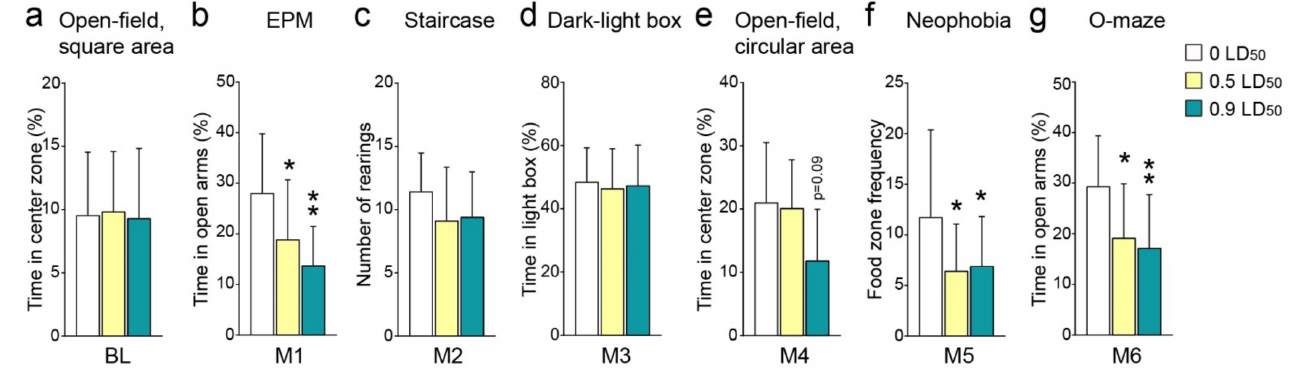
Figure 2. Development of anxiety-like behavior caused by NIMP intoxication. Anxiety-like behaviors were evaluated in NIMP-exposed and CTL animals using a different test every month ( n = 14 for 0 LD50; n = 15 for 0.5 LD50 and n = 16 for 0.9 LD50 group). ( a ) Open-field, square area, at the baseline with the percentage of time spent in the center zone (9.6 ± 1.3 for 0 LD50; 9.9 ± 1.2 for 0.5 LD50 and 9.4 ± 1.4 for 0.9 LD50). ( b ) EPM at 1 month with the percentage of time spent in the open arms (28.1 ± 3.1 for 0 LD50; 18.9 ± 3.0 for 0.5 LD50 and 13.8 ± 1.9 for 0.9 LD50). ( c ) Staircase test, 2 months post-intoxication with the number of rearings on the top step (11.5 ± 0.8 for 0 LD50; 9.1 ± 1.1